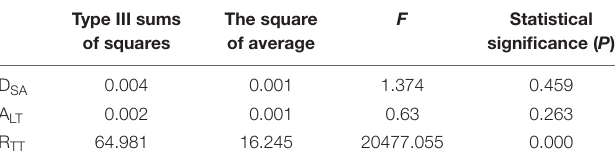
TABLE 2 | Anova analysis of orthogonal test.